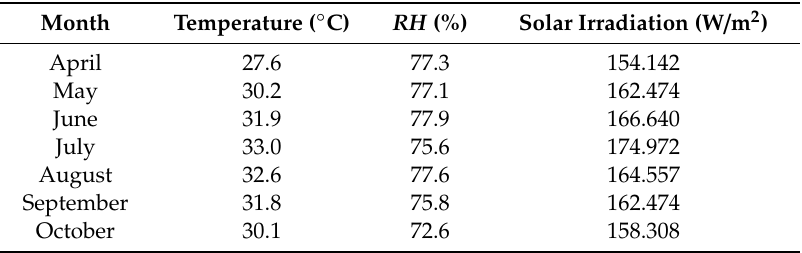
Table 1. Monthly average temperature, relative humidity ( RH ) and solar irradiation of Taichung